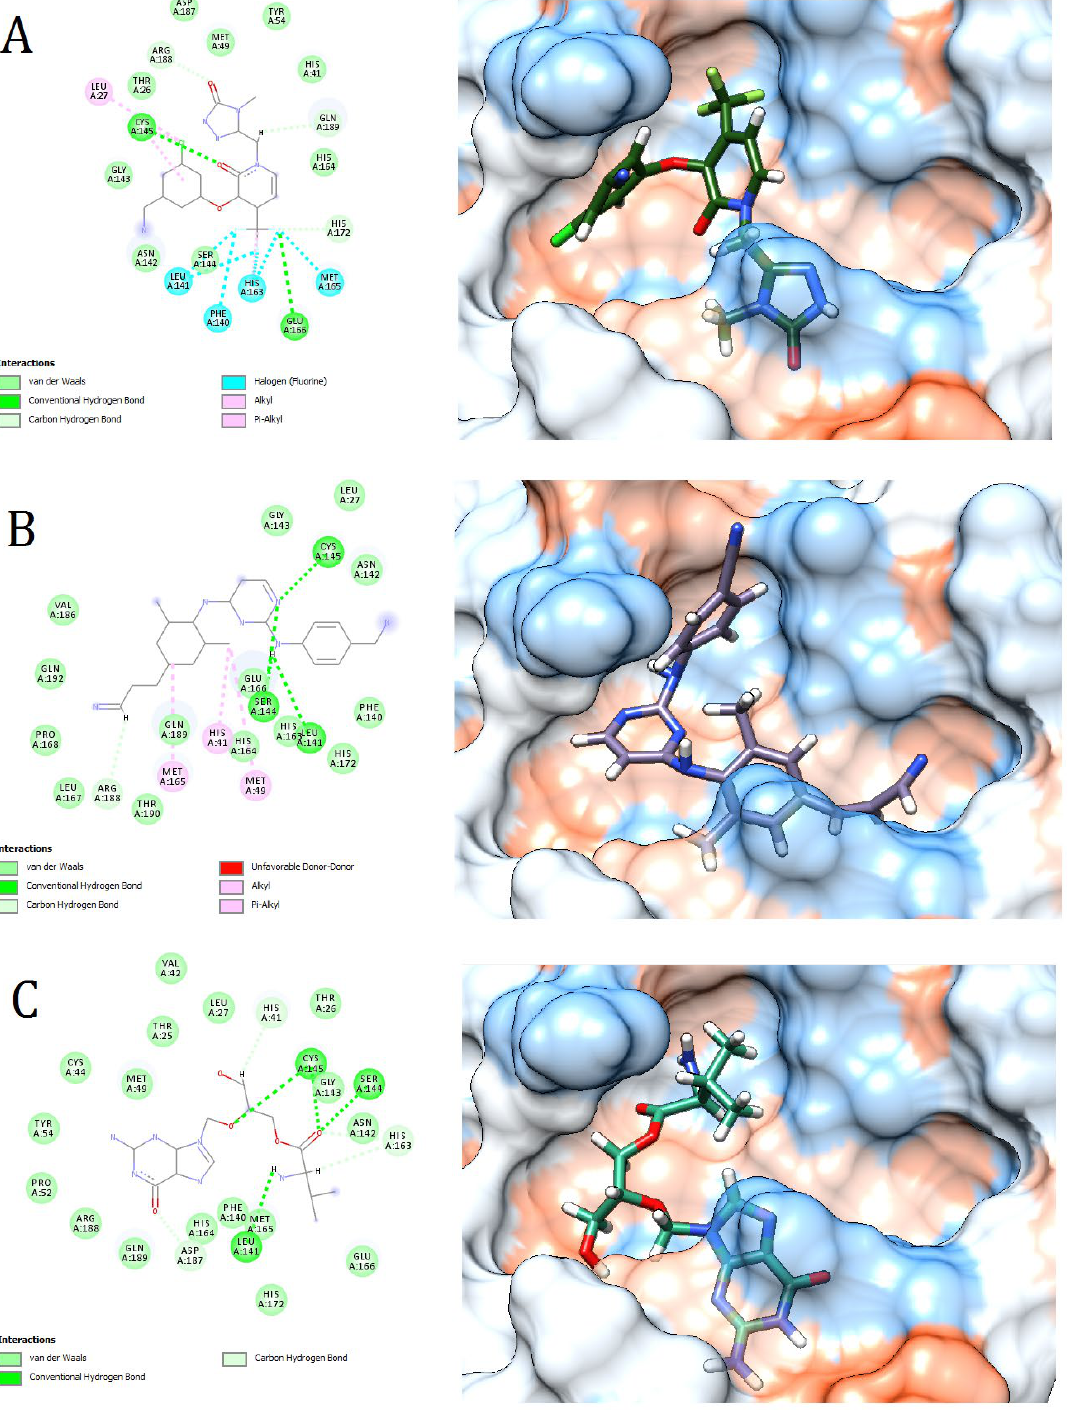
Figure 5. Docking pose visualization for the drugs with the best predicted results (Right) and their 2D receptor-ligand interaction diagram